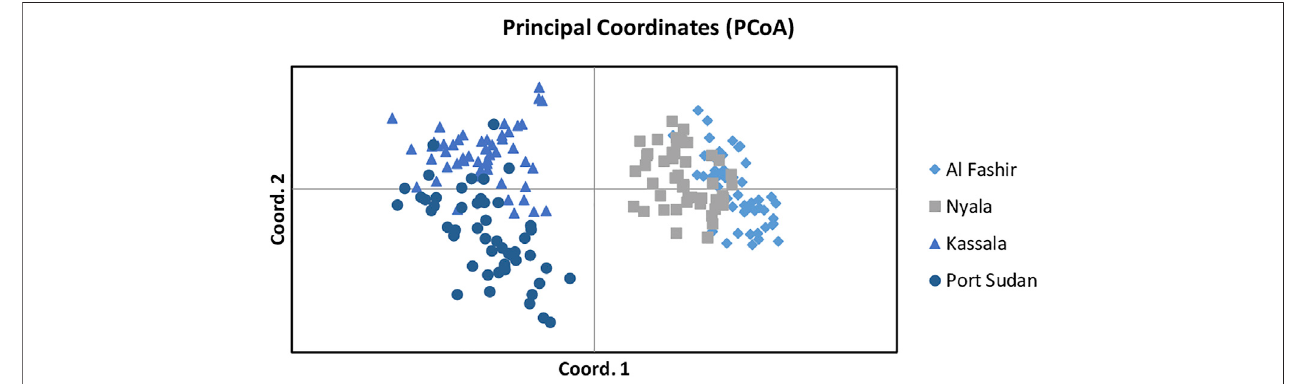
FIGURE 3 | Principal Component Analysis (PCA) on the Sudan Ae. aegypti microsatellite dataset as implemented and plotted using the (GenAlEx) version 6.3. Populations that originated from different regions are presented with different